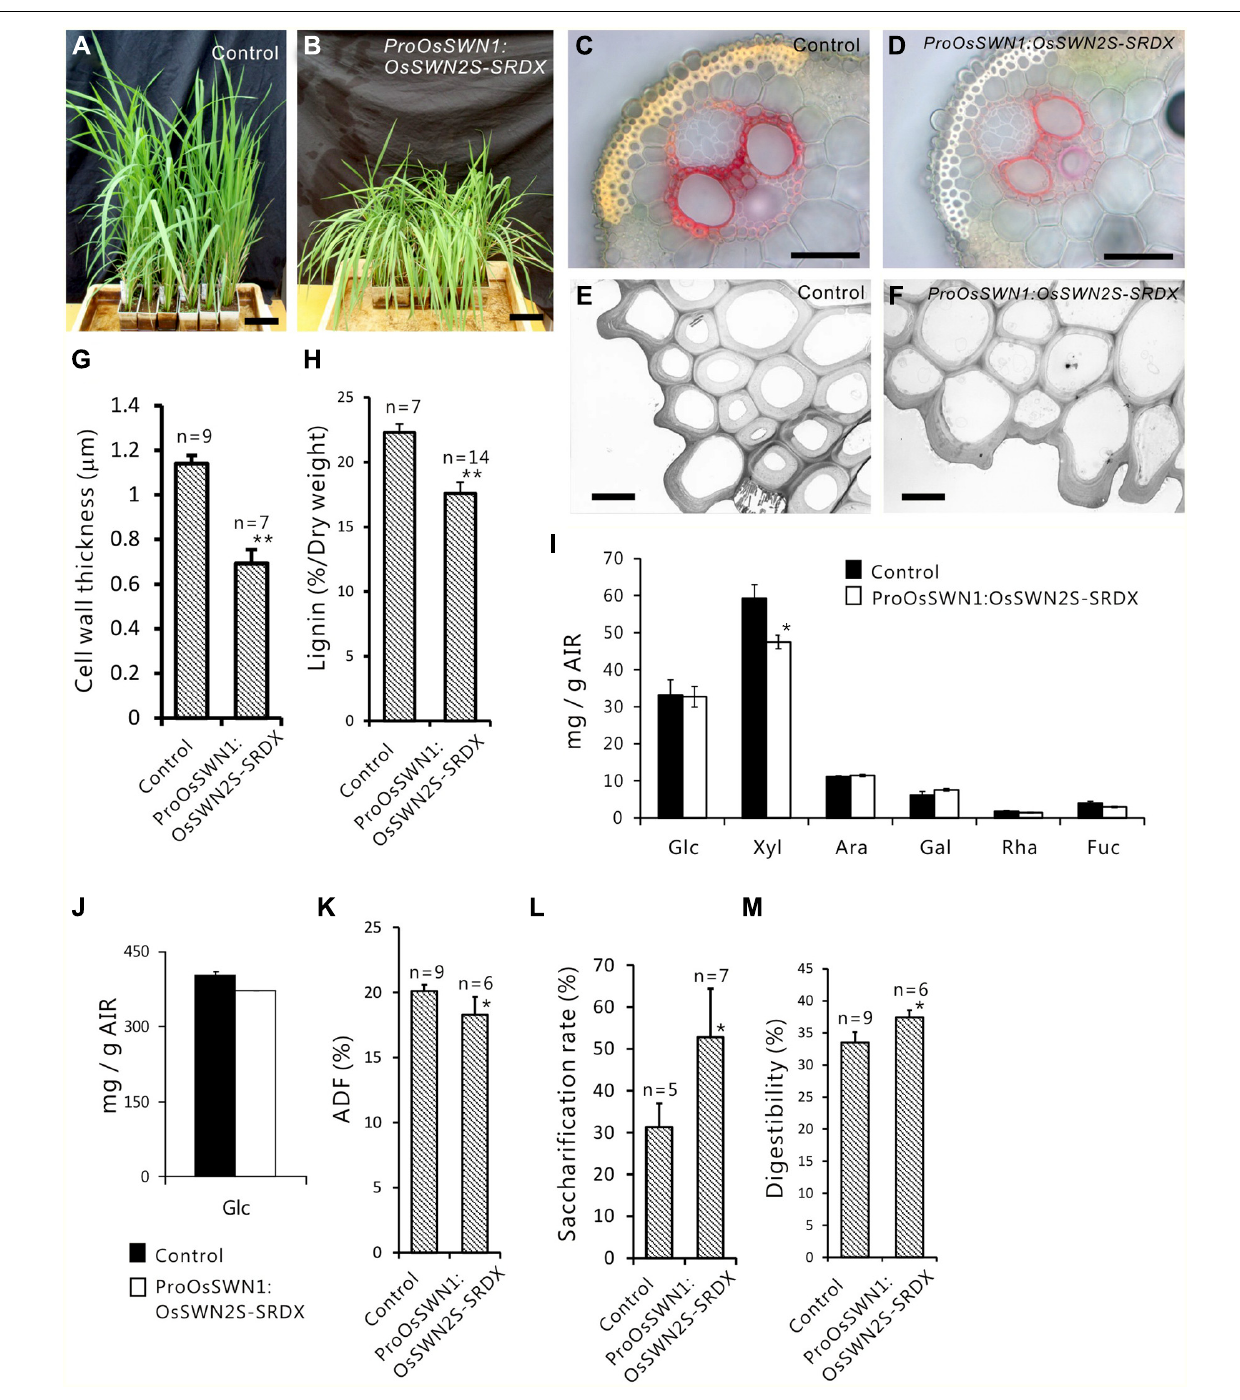
FIGURE 5 | Reduced secondary cell walls in ProOsSWN1:OsSWN2S- SRDX rice . (A) ProOsSWN1:GUS rice plants (control). (B) ProOsSWN1: OsSWN2S-SRDX rice plants. (C–F) Cross sections of leaves of control plants (C, E) and ProOsSWN1:OsSWN2S-SRDX rice plants (D, F) stained with phloroglucinol to detect lignin (C, D) or observed by transmission electron microscopy (E, F) . (G, H, K–M) Thickness of secondary walls (G) , lignin content (H) , the ADF value (K) , saccharification rate (L) and digestibility as forage (M) of ProOsSWN1:GUS rice plants (control) and